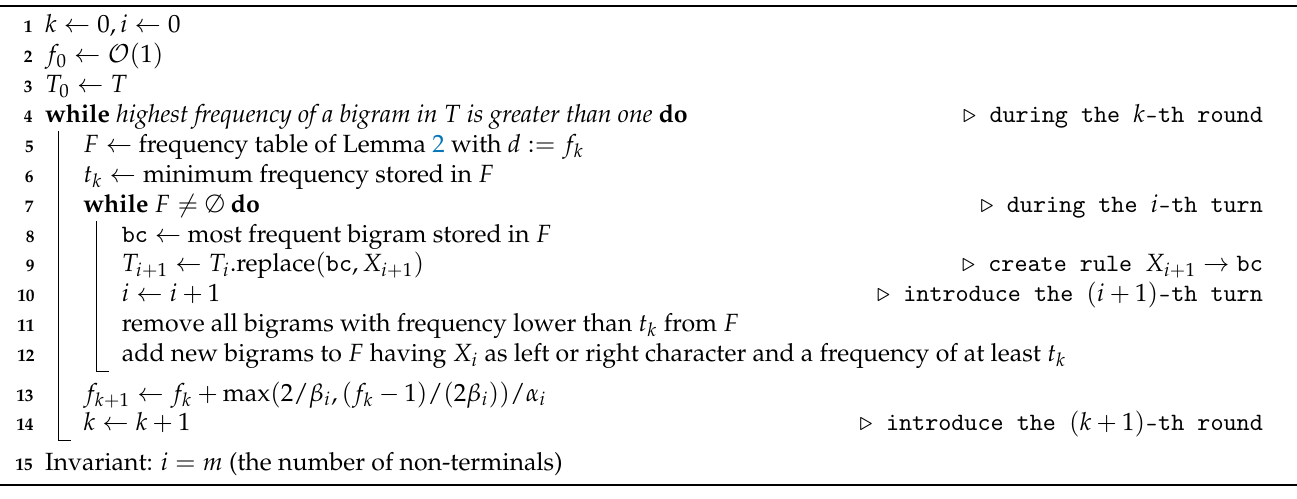
Algorithm 1: Algorithmic outline of our proposed algorithm working on a text T with a growing frequency table F . The constants α i and β i are explained in Section 2.3. The same section shows that the outer while loop is executed O ( lg n )